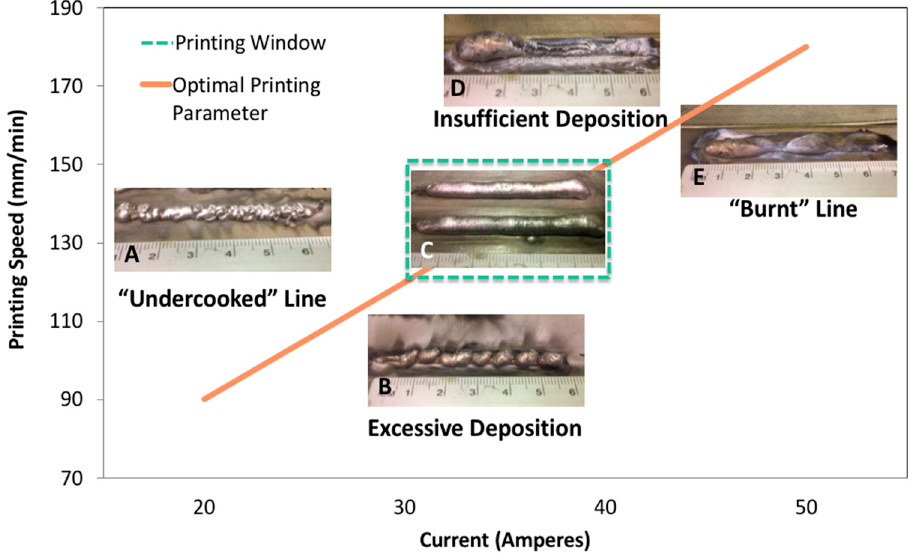
Figure 2. Visual representation of the macroscopically appearance of printed lines created under different printing conditions.